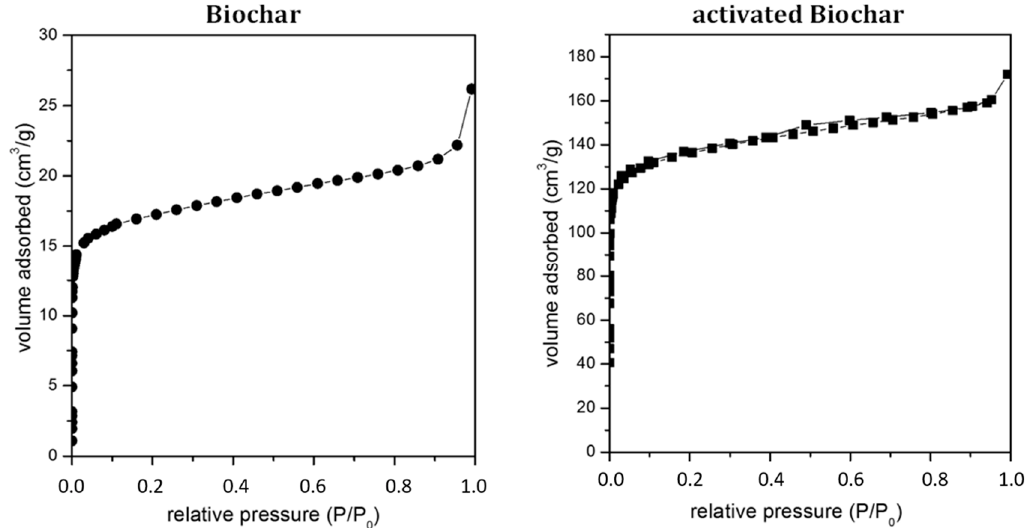
Figure 2. Isotherm graph recorded for biochar characterization, according to IUPAC classification.